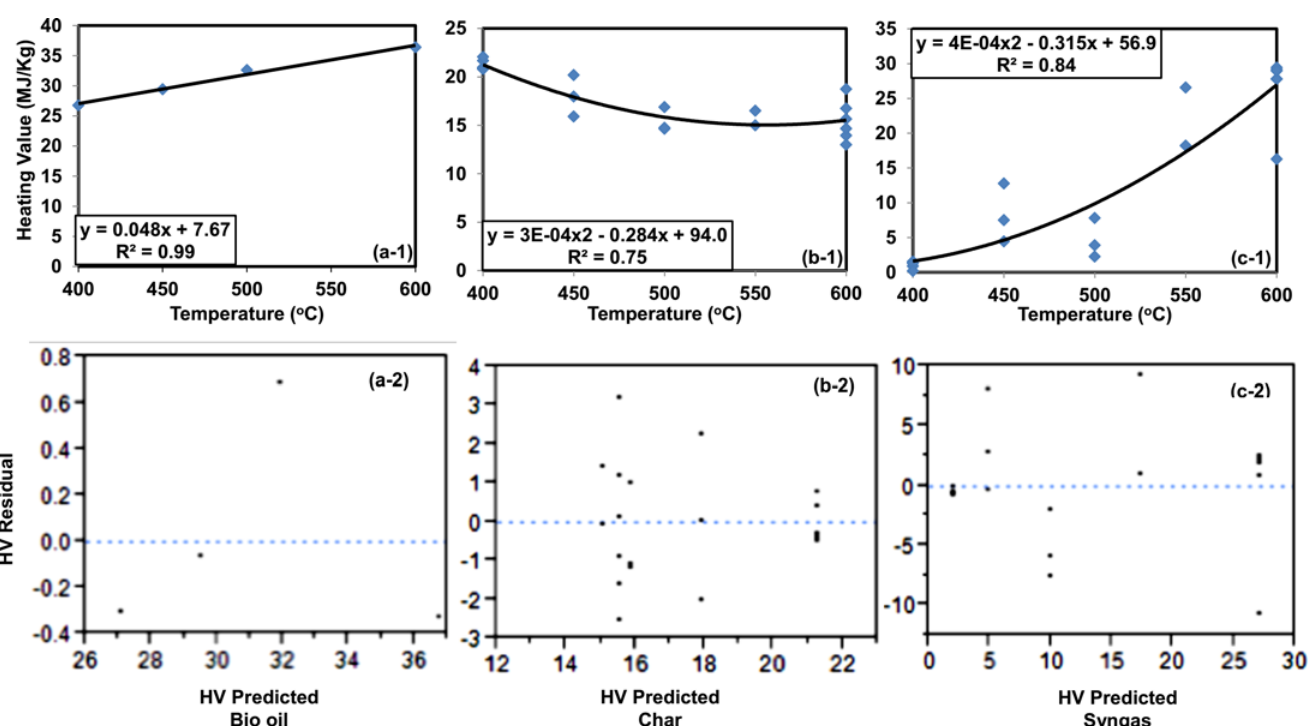
Fig 1. Energy content models of pyrolysis product s [a-1 Bio oil, b-1 Char, and c-1 Gas] and residual plots of models generated [a-2 Bio oil, b-2 Char, and c-2 Gas].